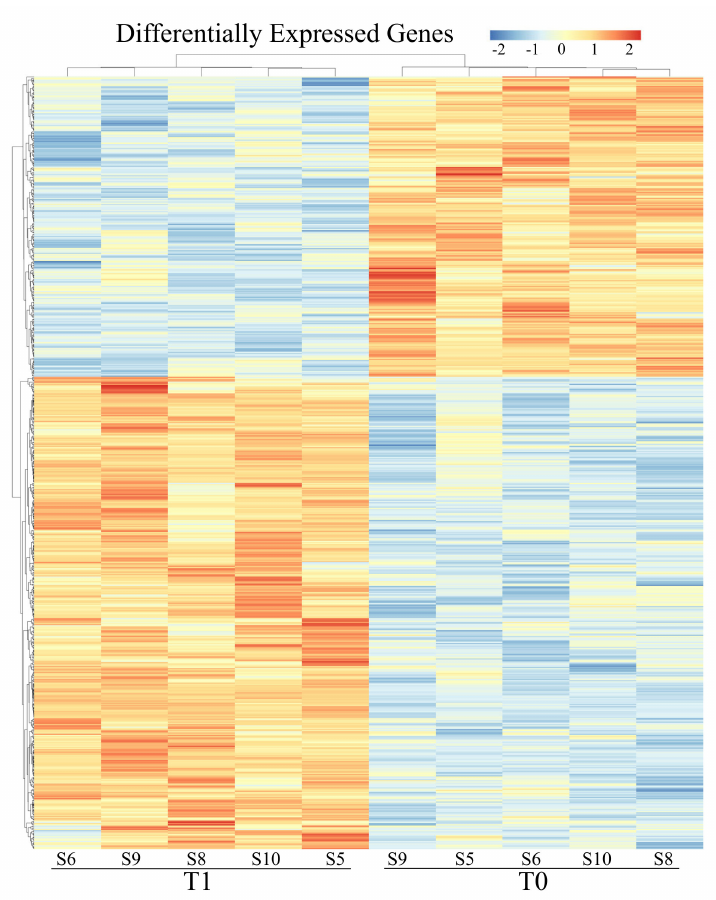
Figure 2. Heat maps of di ff erentially expressed genes basing on exon counts. Clustering resulted to be accurate and distinct. Legend above displays range of